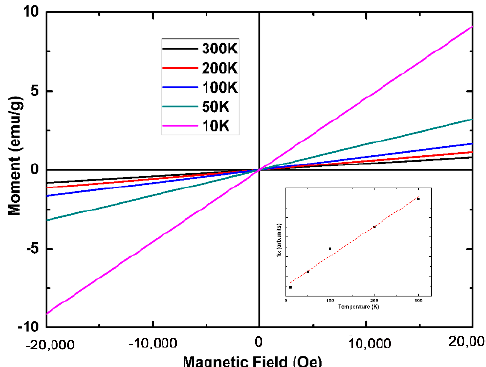
Figure 5. The M-H curves of Mnq 2 nanorods measured by SQUID VSM at different temperatures, with the plot of susceptibility vs. temperature in the inset.